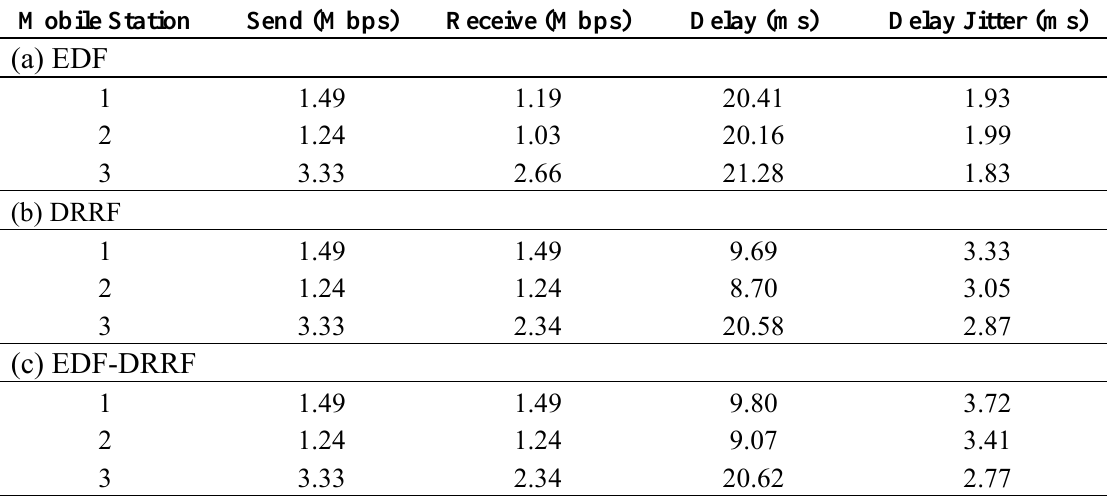
Table 8. System Throughput, Delay, and Delay Jitter with Enforced Deadline: 2 Well-Behaved Flows and 1 Ill-Behaved Flow in Overload Scenario (a) EDF, (b) DRRF, and (c) EDF-DRRF